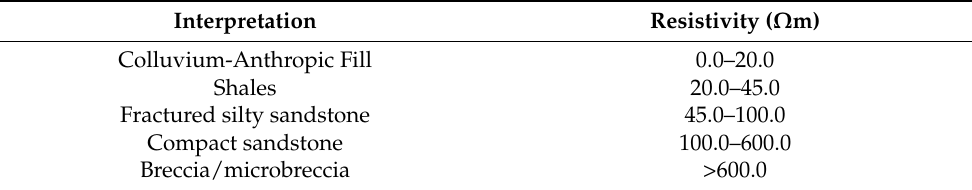
Table 8. Geoelectrical interpretation of the lithology based on VESs.